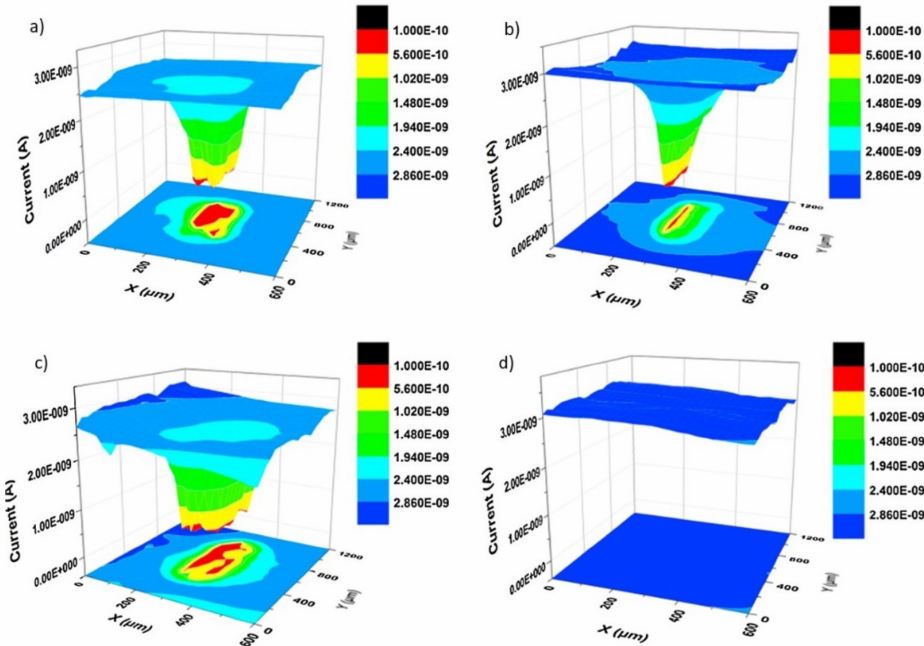
Figure 13. SECM measurements of the coating defect area before and after the self-healing process: ( a ) original defect in wax-free coating, ( b ) defect in the wax-free coating after two-step healing, ( c ) original defect in SMC coating, and ( d ) defect in SMC coating after two-step healing. Reproduced with permission of Elsevier [41]. Some like 1.000E-10 mean 1.000 × 10 − 10